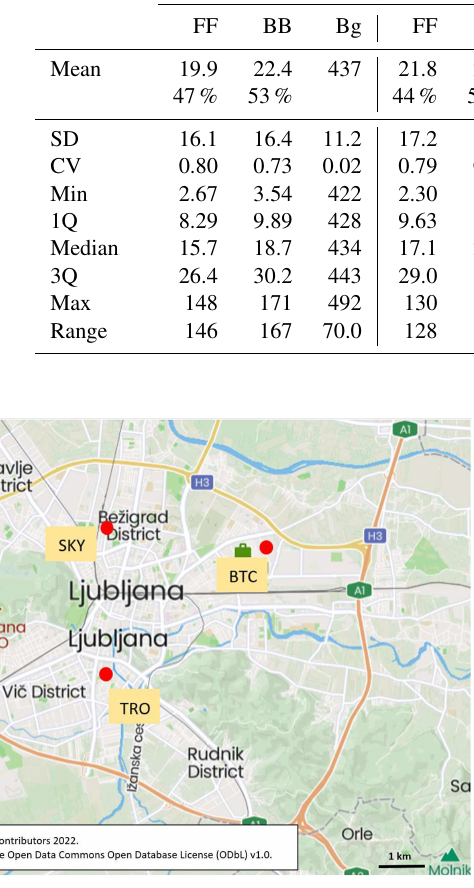
Figure 1. Measurement locations on the map of Ljubljana. HW shows the location of the traffic measurement next to the